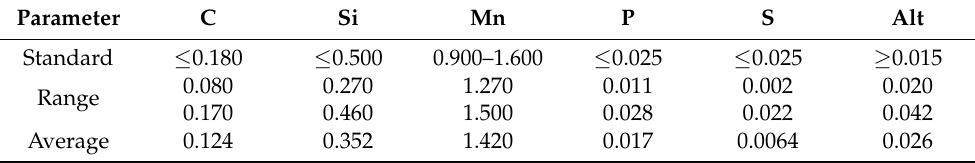
Table 7. Composition range of DH36 steel (in wt %) from industrial production.